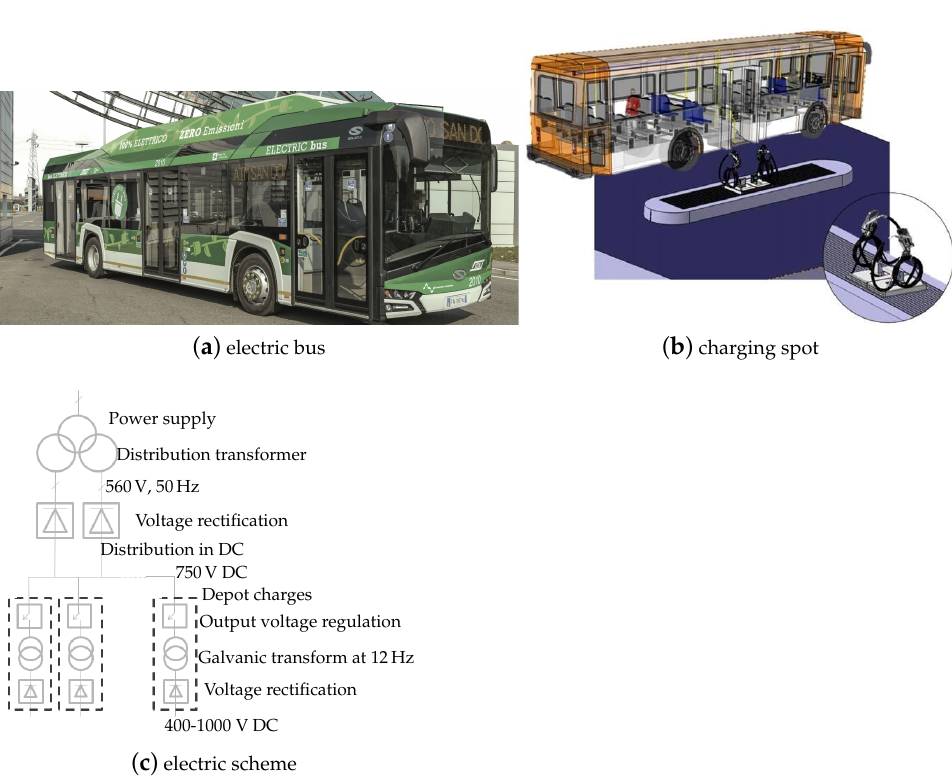
Figure 1. Charging of electric buses. ( a ) Example of an electric bus. ( b ) Charging spot realization. ( c ) Electric scheme of the